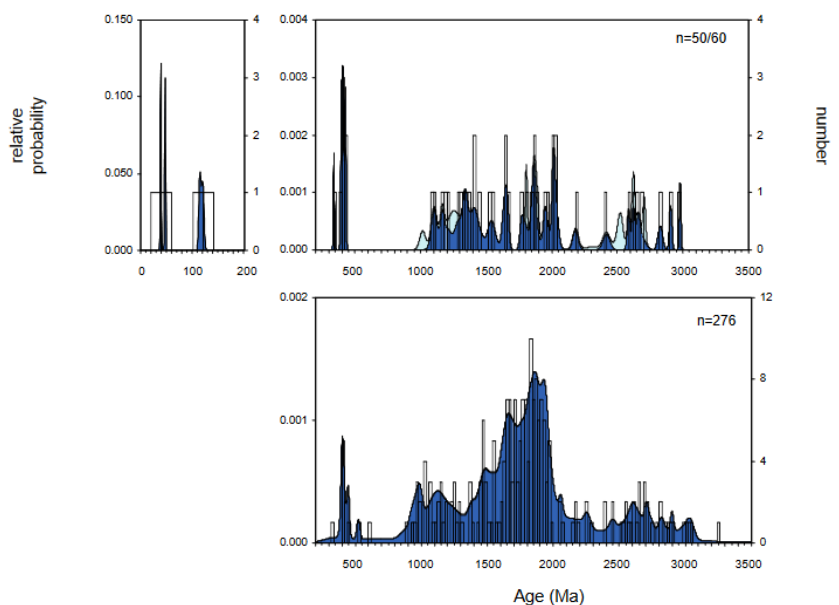
Figure 14. Upper diagram is a probability density plot of zircon ages in a Middle Eocene sample from Site 349 (314.39 m depth) determined by SHRIMP. Dark blue areas are zircons with <10% discordance, pale blue areas are zircons with >10% discordance. ‘n’ is number of zircons with <10% discordance in the total zircon population. Lower plot shows zircons from samples of Late Oligocene volcaniclastic sandstones dredged from the western Jan Mayen Fracture Zone.